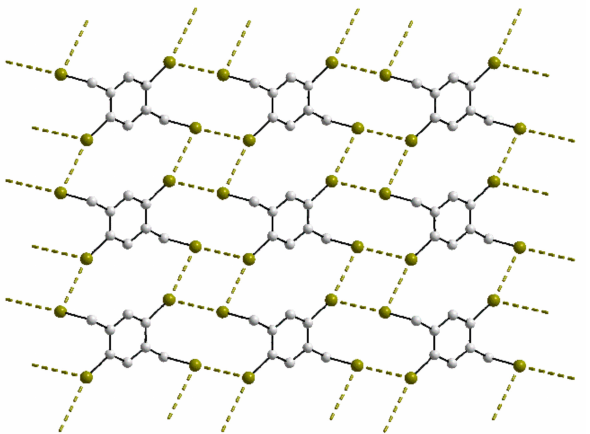
Figure 13. A view of the two-dimensional array in the crystal of a polymorph of the all-bromide congener of 20 (see